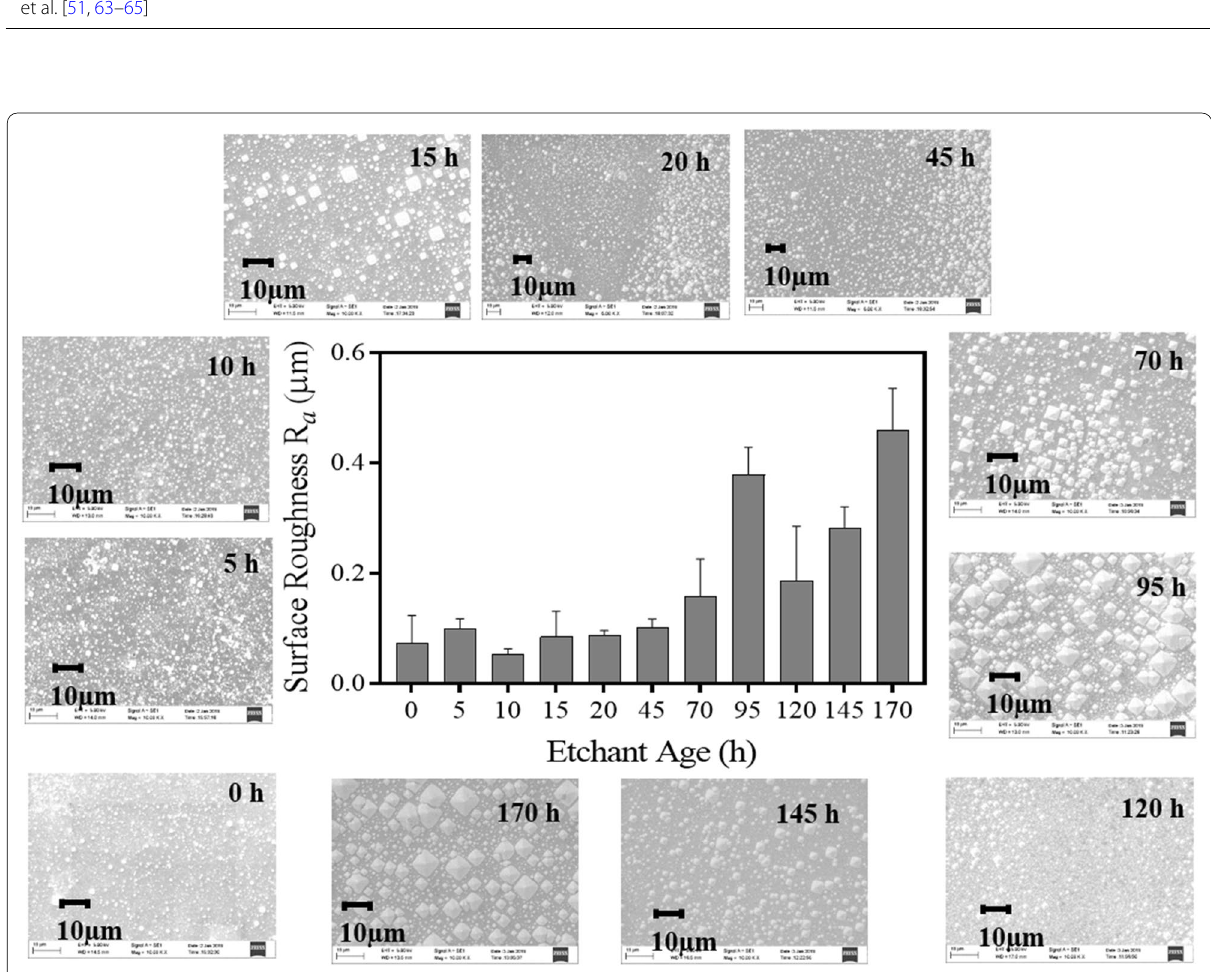
5 wt% TMAH with varying +